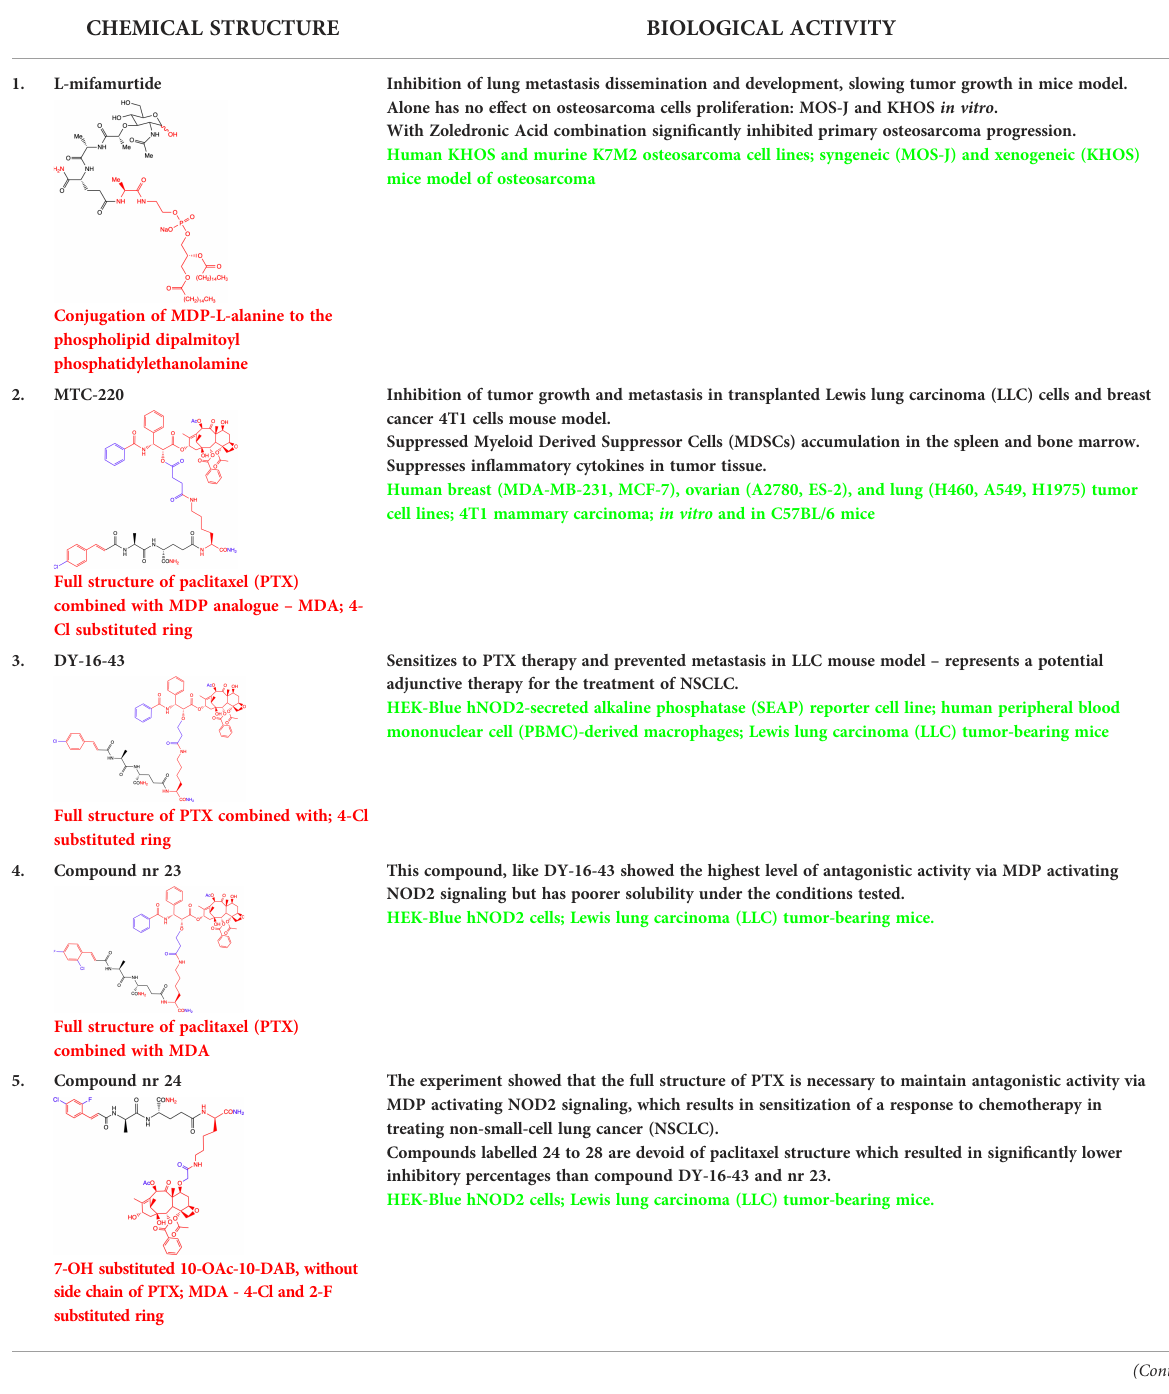
TABLE 2 MDP derivatives with cytotoxic /antitumor